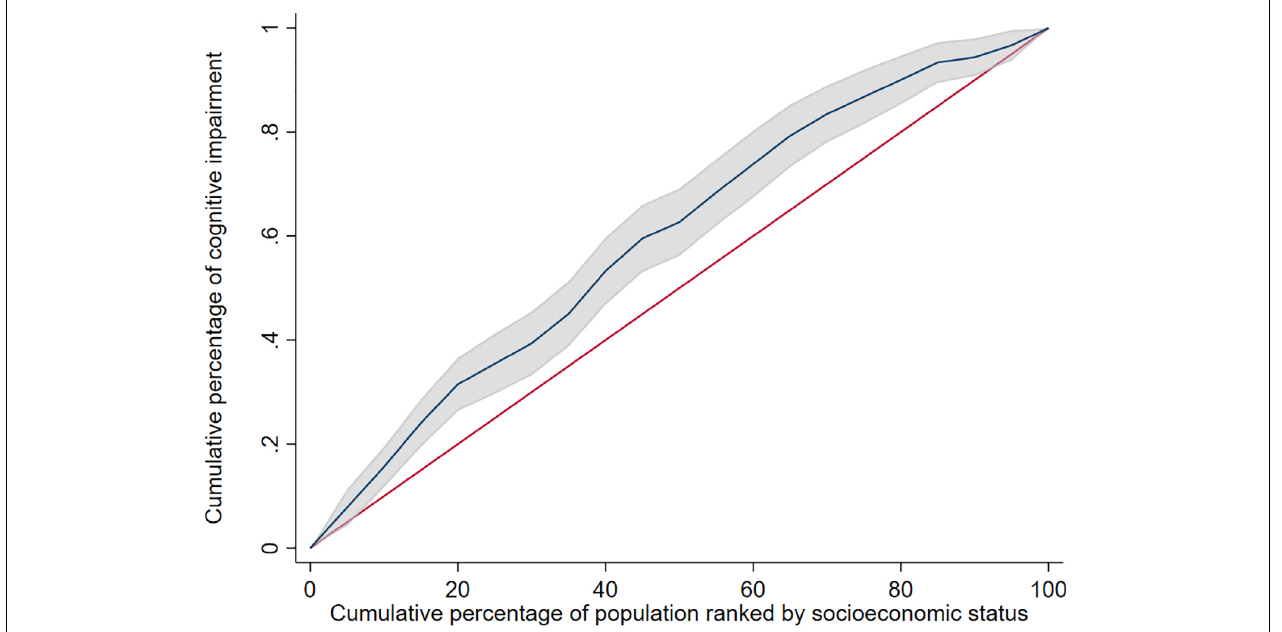
FIGURE 2 | Concentration curve of cognitive impairment in female elderly. The shadow around the curve represent